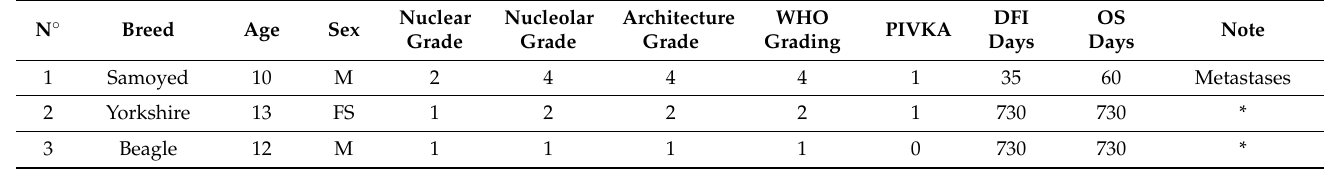
Table 2. Signalment (breed, age, gender), histological grades, immunohistochemical result and follow up results. * censored case (alive after 2 years free from metastasis and/or local recurrences; dead for tumour unrelated